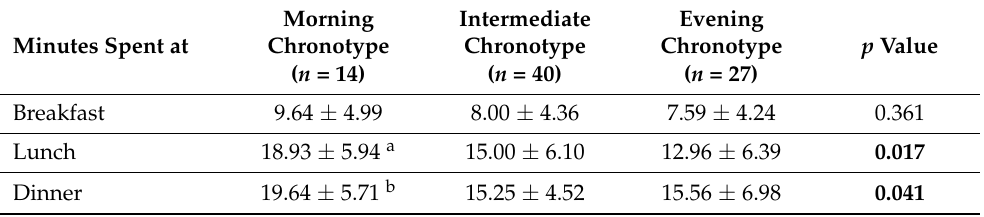
Table 4. Differences in eating speed of main meals between chronotype